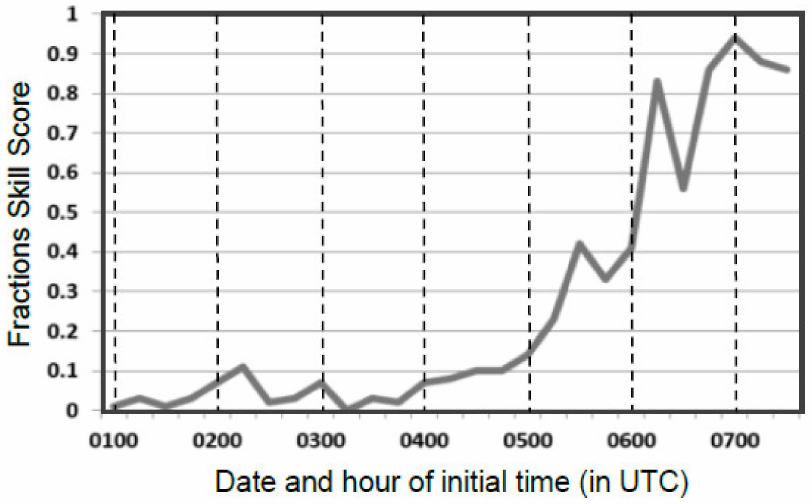
Figure 7. Fractions skill score (FSS) of 48-h QPFs over Taiwan, targeted for the period from 1200 UTC 7 to 1200 UTC 9 August during TY Morakot (2009), from six-hourly time-lagged ensemble hindcasts made from 0000 UTC 1 until 1200 UTC 7 August (labelled along abscissa in the format of “ddhh” for date and hour in UTC),